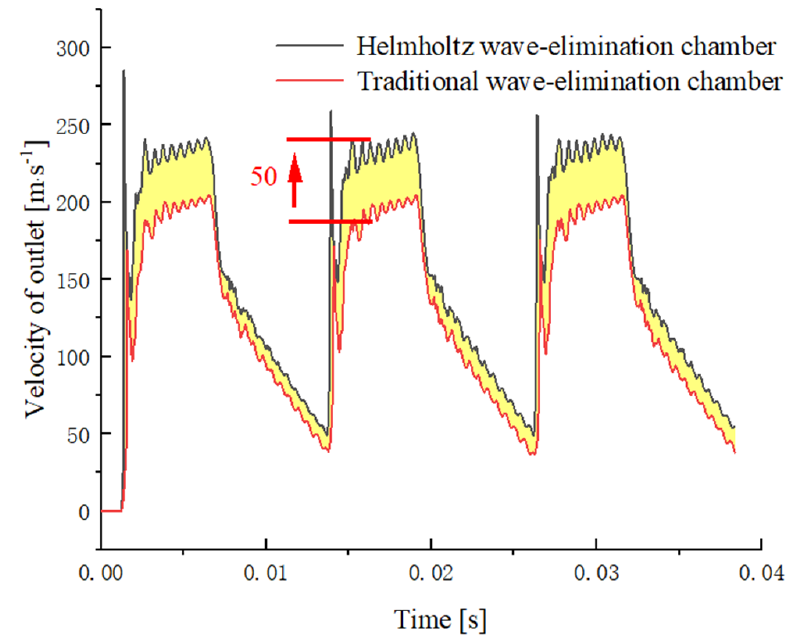
Figure 7. Velocity of the two chambers. We observed the effect of the change in the expansion ratio on the outlet pressure of the Helmholtz wave-elimination chamber. When the pulsating ejection frequency was 80 Hz, the total pressure of pulsating ejection was 0.2 MPa, 0.3 MPa, and 0.4 MPa, and the temperature was 300 K, the cold air exhaust stage was subsonic flow, the static pressure value of the fixed nozzle was 0.1 MPa, and the corresponding expansion ratios ε were 2, 3, and 4, respectively. It can be seen from Figure 8 that reducing the expansion ratio slows down the pressure front jump speed and pressure drop speed. Therefore, the Helmholtz chamber would have a better effect on the end jet at a high expansion